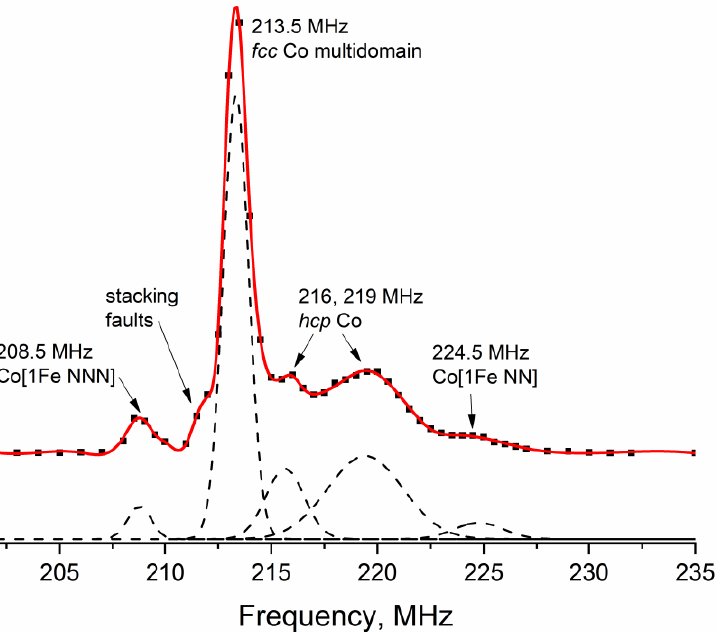
Figure 3. 59 Co Internal Field NMR spectrum of the initial Co powder. Experimental points are shown with black squares; interpolation curve is shown in red. Dashed line shows the theoretical Gaussian lines used in the spectral decomposition.